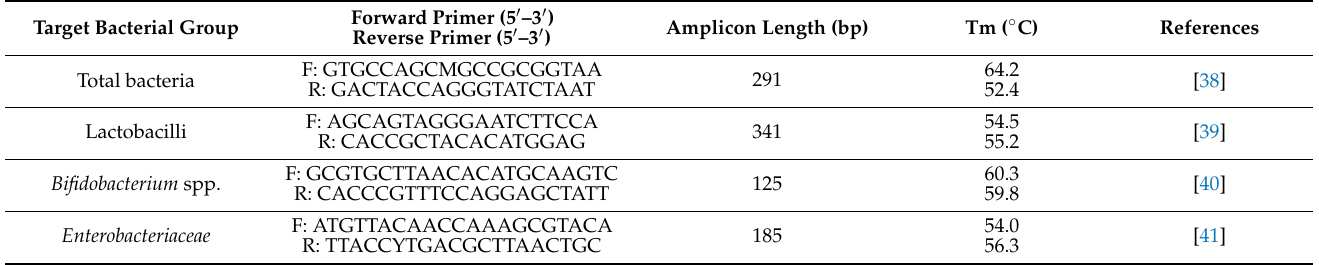
Table 2. List of forward and reverse primers used for the bacterial quantification by QPCR. Target Bacterial